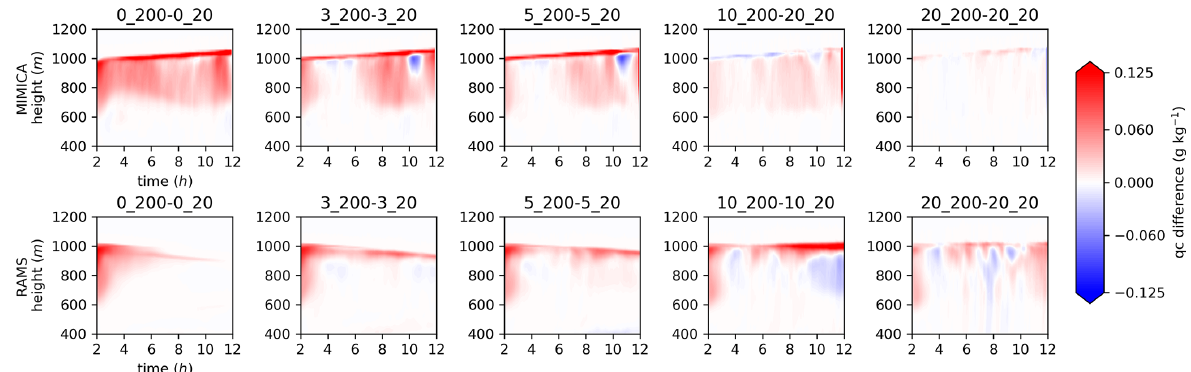
Figure 7. Differences in cloud droplet mixing ratio (qc) for simulation pairs with the same accumulation mode concentration (i.e. ACx_AK200–ACx_AK20) shown for MIMICA and RAMS. The first 2h of simulations, considered as the spin-up period, are excluded. A Student’s t test with a 95% confidence level shows that the (time mean) differences are statistically significantly different for each pair of simulations, except for the pair AC20_AK200 and AC20_AK20 in MIMICA. For figure clarity, the plot titles have been abbreviated; the first number refers to the accumulation mode and the second to the Aitken mode concentration in cubic centimetres, i.e. 0_20 refers to AC0_AK20.